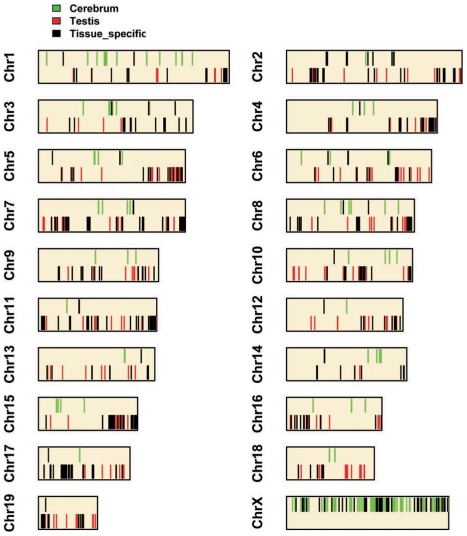
Profiles of tissue-specific and NO-intensive regions over each chromosome.Genomic regions showing higher NO intensity in mouse cerebrum (red bars, lower panel) and testis (green bars, upper panel) are plotted. Some of these regions that harbor cerebrum- and testis-specific genes are highlighted in black. There is no information for Y.